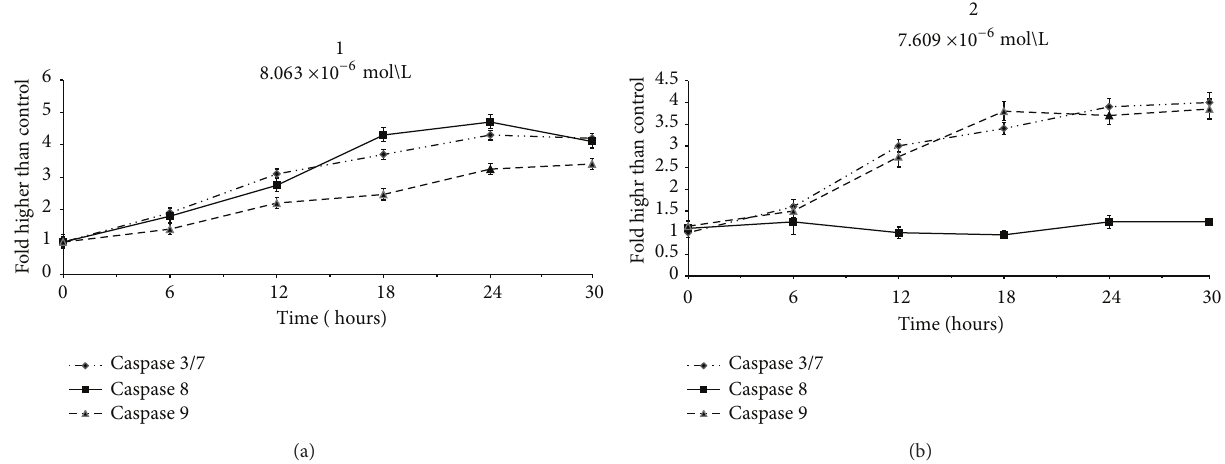
Figure 15: Relative luminescence time-dependent expression of caspases-3/7, -8, and -9 in MCF-7 cells treated with (1) and (2) at concentrations of 8 × 10 −6 mol/L and 7.6 × 10 −6 mol/L, respectively, after 24 hours incubation.